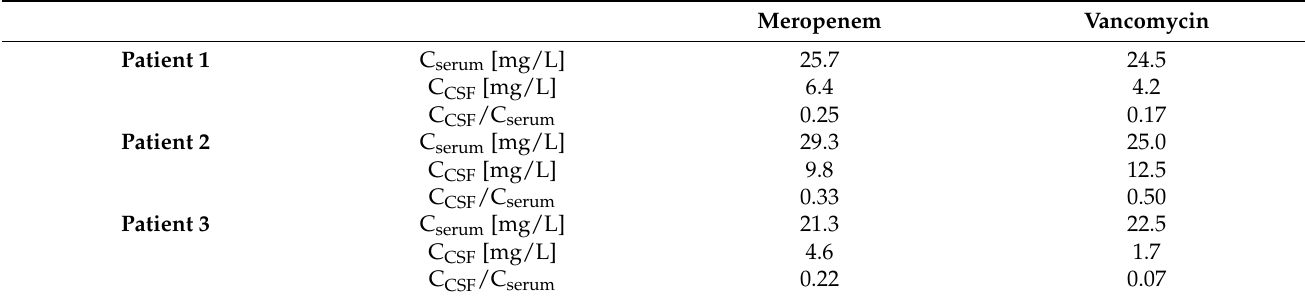
Table 2. Serum and CSF concentrations in each patient 24 h after infusion start.